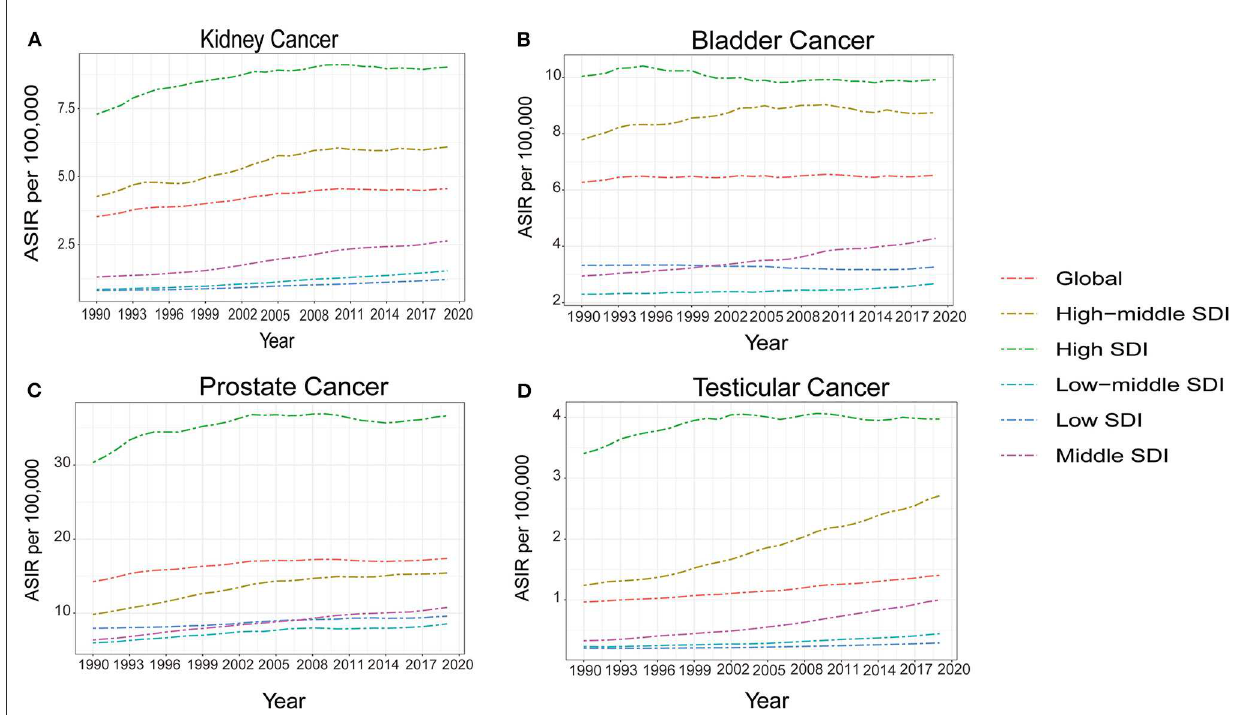
FIGURE3 The temporal trends of age standardized incidence rate (ASIR) for kidney cancer (A) bladder cancer (B) prostate cancer (C) and testicular cancer (D) from 1990 to 2019, for both sexes by socio-demographic index (SDI).